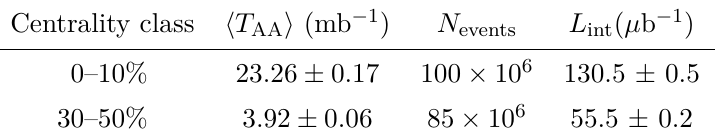
Table 1 . Average nuclear overlap function, number of events, and recorded integrated luminosities for the two centrality classes used in the